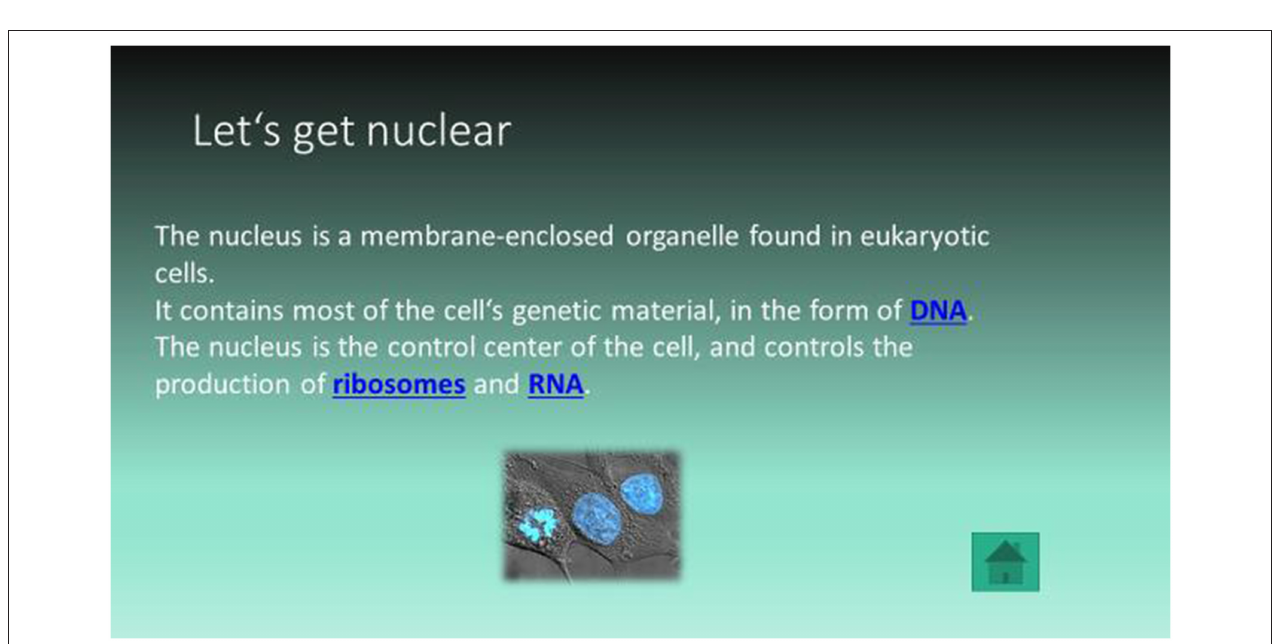
FIGURE 4 | The screenshot was taken from the second section of the hypertext showing blue hyperlinks (the image is licensed for reprint or used with the permission of the copyright holder; TenOfAllTrades at English Wikipedia, 2007). The house button leads the learners back to the menu page (the button is our own creation).